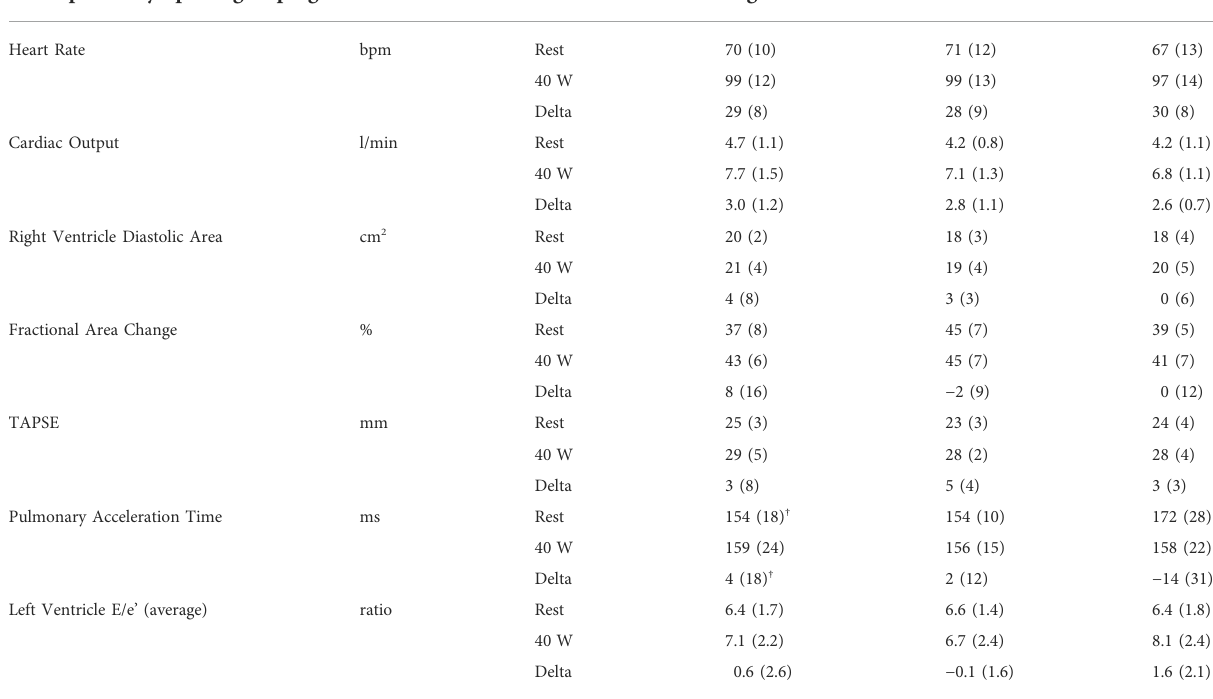
TABLE 5 Rest and exercise (40 W) echocardiography for Long-CoV, no-longer symptomatic (ns)-CoV and Controls. TAPSE; tricuspid annular plane systolic excursion. Self-reported symptom